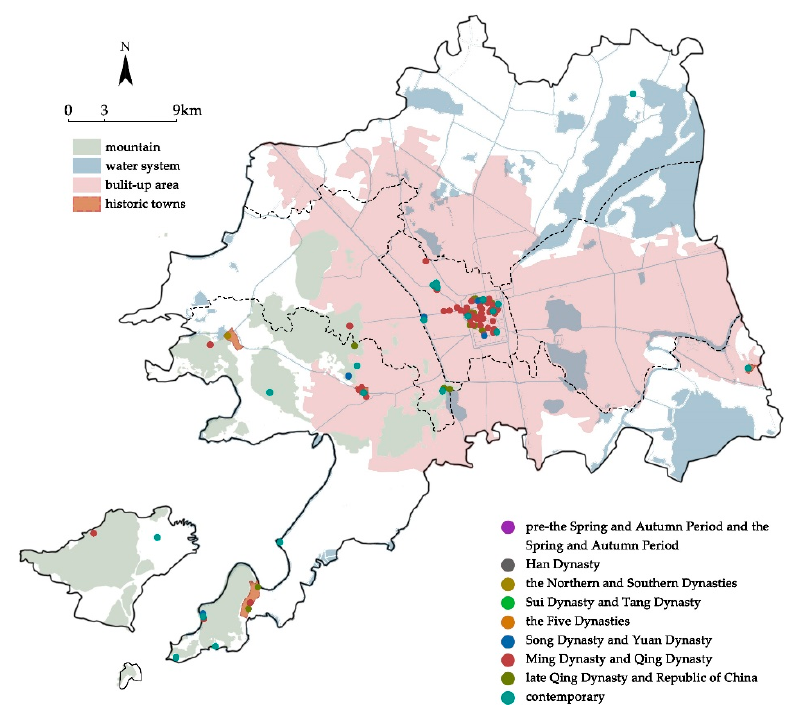
Figure 8. Distribution of traditional gardens.